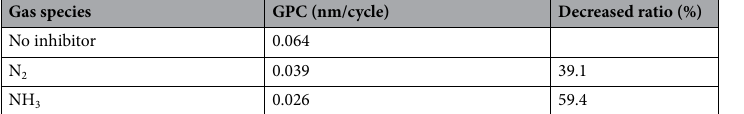
Gas species GPC